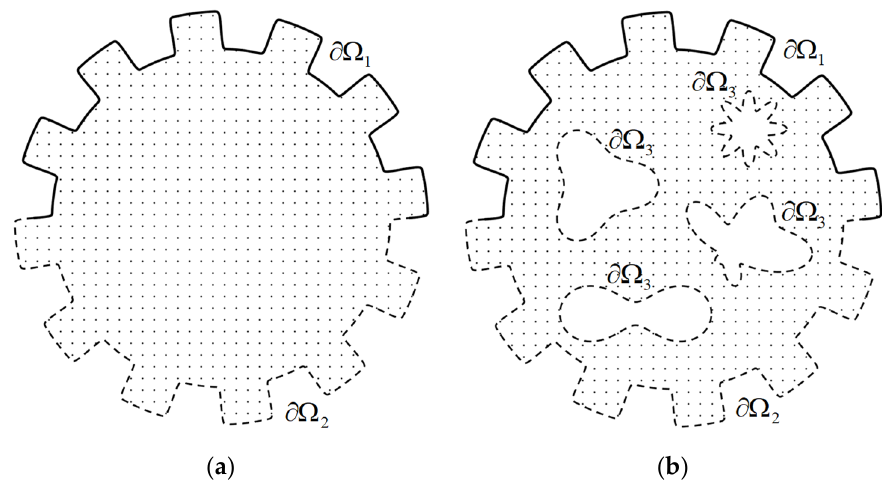
Figure 1. Inverse problem in the domain of ( a ) simply connected ( b ) multiply connected.